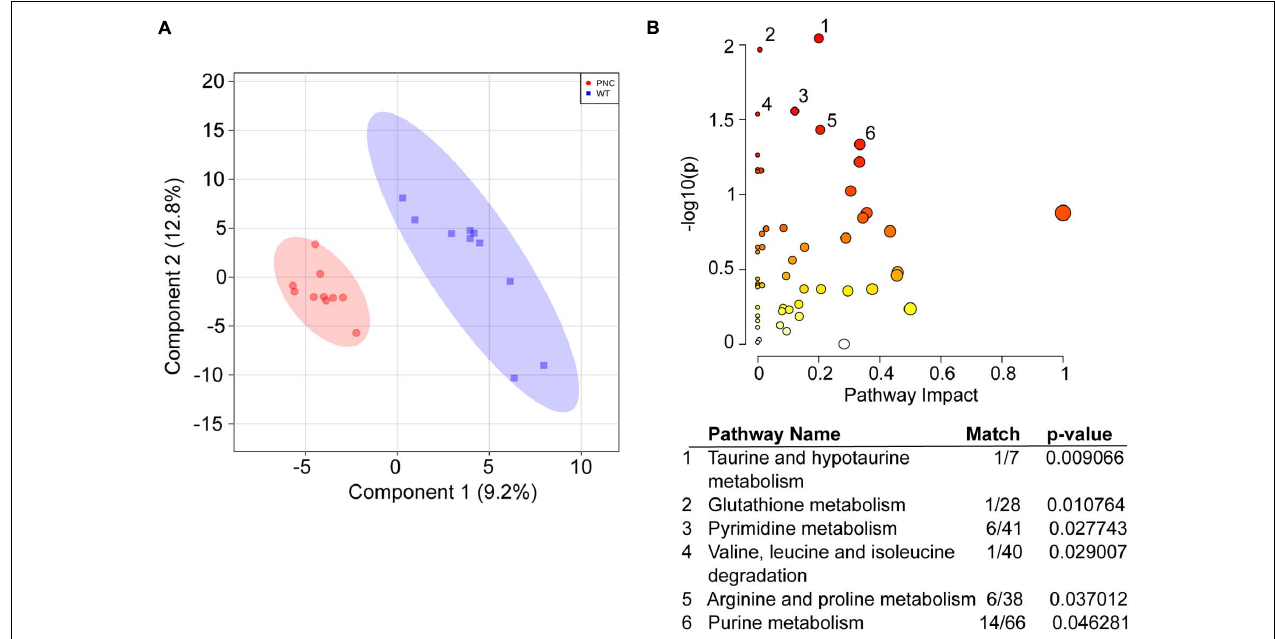
FIGURE 4 | Metabolic pathways significantly altered upon HRAS G12V induction in PNCs. (A) Partial Least Squares—Discriminant Analysis (PLS-DA) score plot shows separation of the preneoplastic cell (PNC) and control (WT) groups. The first and second components explain 9.2 and 12.8% of the variation, respectively. Different colors and shapes correspond to PNC, red circle and WT, blue square. (B) Scatter plot of Danio rerio KEGG metabolic pathways significantly altered upon HRAS G12V induction. The p -values from the pathway enrichment analysis are shown in darker color indicating more significant changes within a pathway, while the pathway impact values from the pathway topology analysis are depicted by the size of the node. Significantly ( p < 0.05) impacted pathways are numbered and tabulated: 1, Taurine and hypotaurine metabolism; 2, Glutathione metabolism; 3, Pyrimidine metabolism; 4, Valine, leucine and isoleucine degradation; 5, Arginine and proline metabolism; 6, Purine metabolism. The match values indicate the number of metabolites identified within the KEGG pathway.